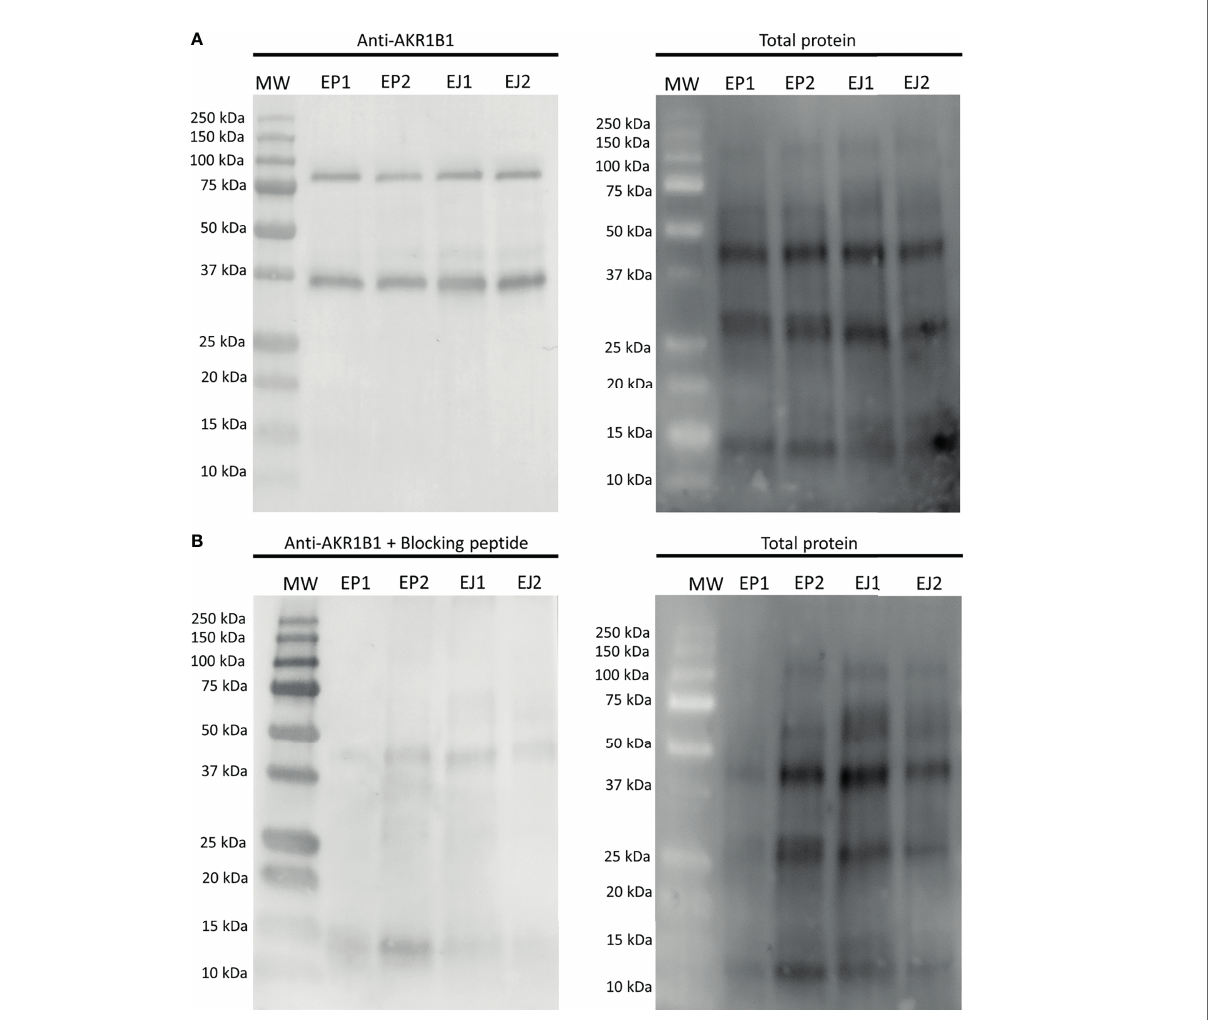
FIGURE 1 | Representative Western blot analysis of (A) anti-AKR1B1 and (B) the corresponding blocking peptide in epididymal and ejaculated sperm, and their total protein controls for both membranes. MW, molecular weight; EP1 and EP2, epididymal sperm samples; EJ3 and EJ4, ejaculated sperm